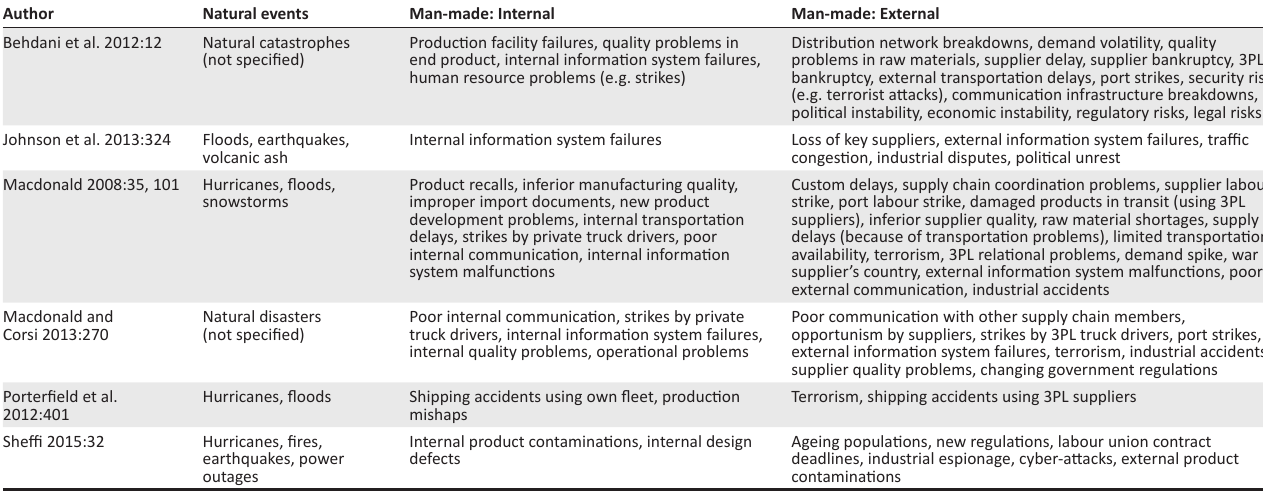
TABLE 2: Categorising disruptions in terms of the inherent